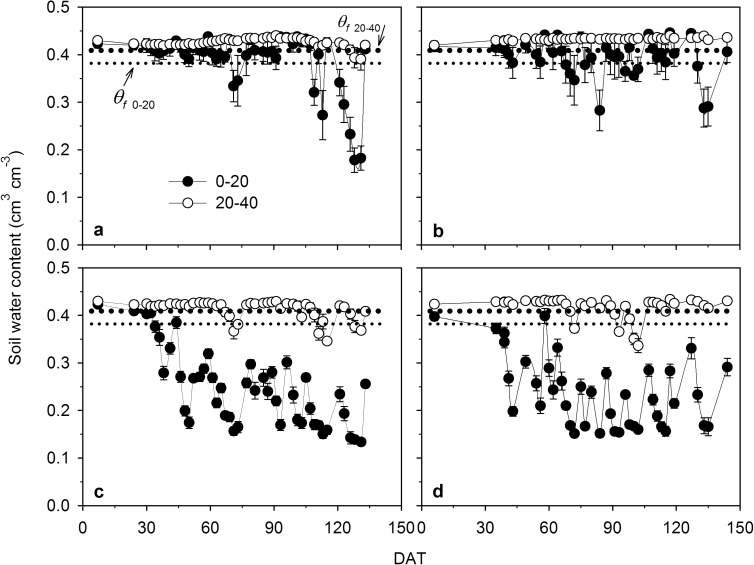
Dynamics of averaged soil water content at different soil layers under GCRPSsat and GCRPS80% in 2013 (a and c) and 2014 (b and d) for Exp. 1. GCRPSsat and GCRPS80%, ground cover rice production system keeping root zone average soil water content near saturation and 80–100% of field water capacity, respectively. Vertical error bars represent standard errors (with the replicate number of 3 for GCRPSsat and 9 for GCRPS80%, respectively), and DAT is days after transplanting. The bold and fine dotted lines indicate the field water capacity of 0–20 (θf 0–20) and 20–40 cm (θf 20–40) soil layers, respectively.